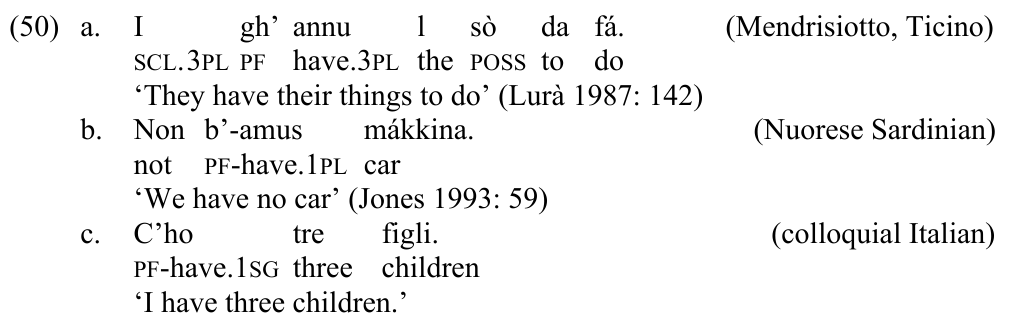
figli. (colloquial